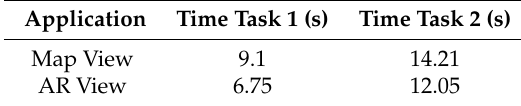
Figure 10. Time taken to complete the tasks using Map View and AR view. Table 5. Average time taken to complete both tasks by the